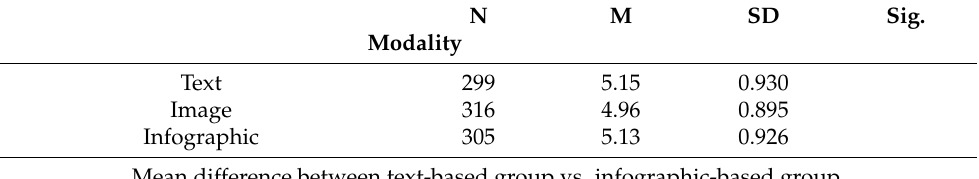
Mean difference between text-based group vs. infographic-based group Mean difference between image-based group vs. infographic-based group